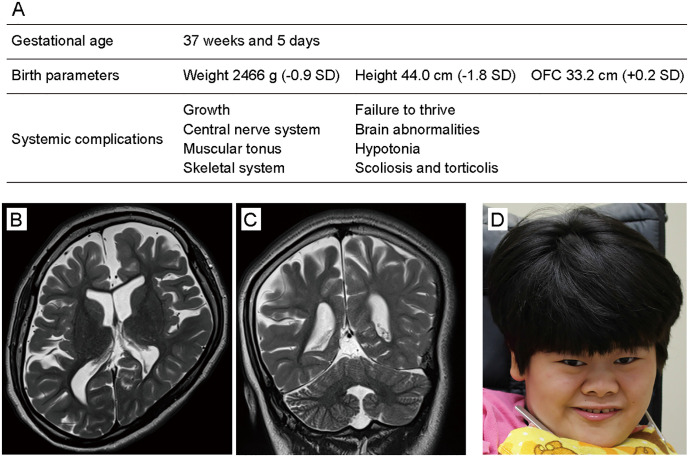
Clinical features of a patient with severe ID.(A) Perinatal information and systemic symptoms of the patient. SD, standard deviation. (B) Brain MRI (T2-weighted imaging) of the patient at 23 years of age (axial imaging). The MRI revealed general cerebral atrophy, especially in the frontal lobe, and hypoplasia of the corpus callosum. (C) Coronal MRI imaging. (D) Patient photograph showing the coarse face, thick eyebrows, hypotelorism, long palpebral fissures, midface hypoplasia, bulbous nose, wide ala nasi, short philtrum, thin upper lip, and hypertrichosis.